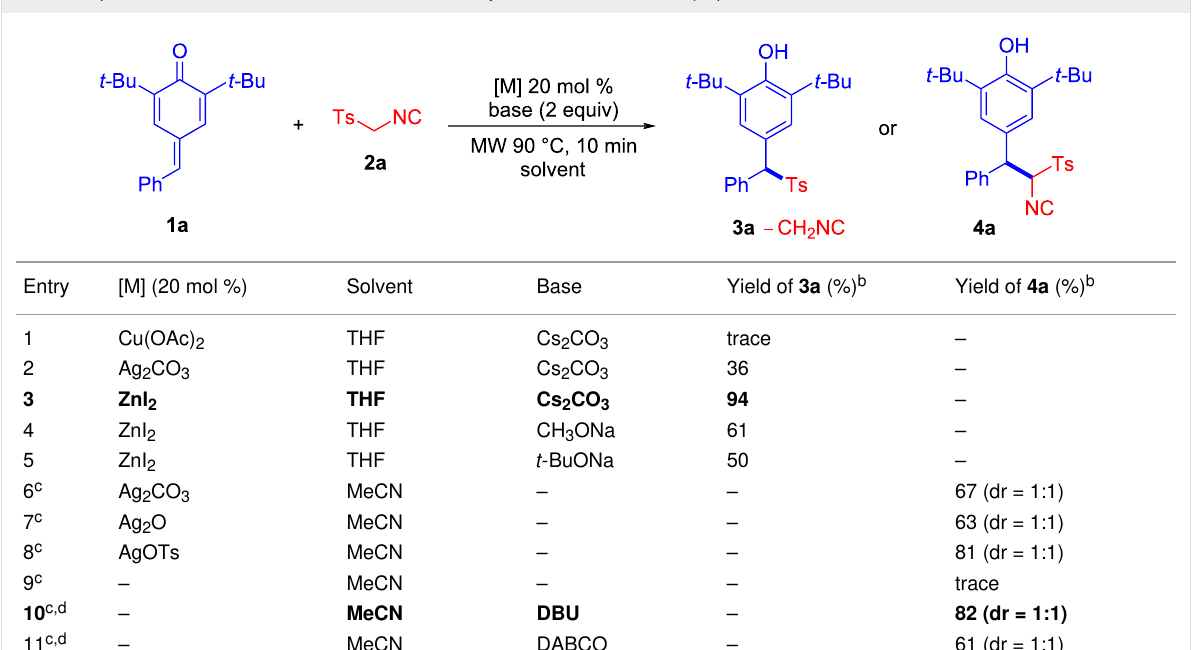
Table 1: Optimization of the reaction conditions for the sulfonylation and isonitrilation of p -quinone methides with TosMIC.